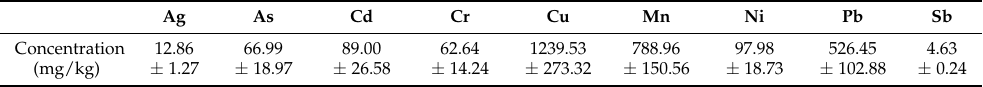
Table 1. Heavy-metal concentrations in the sampling soil. Data are presented as means ± standard deviations ( n =